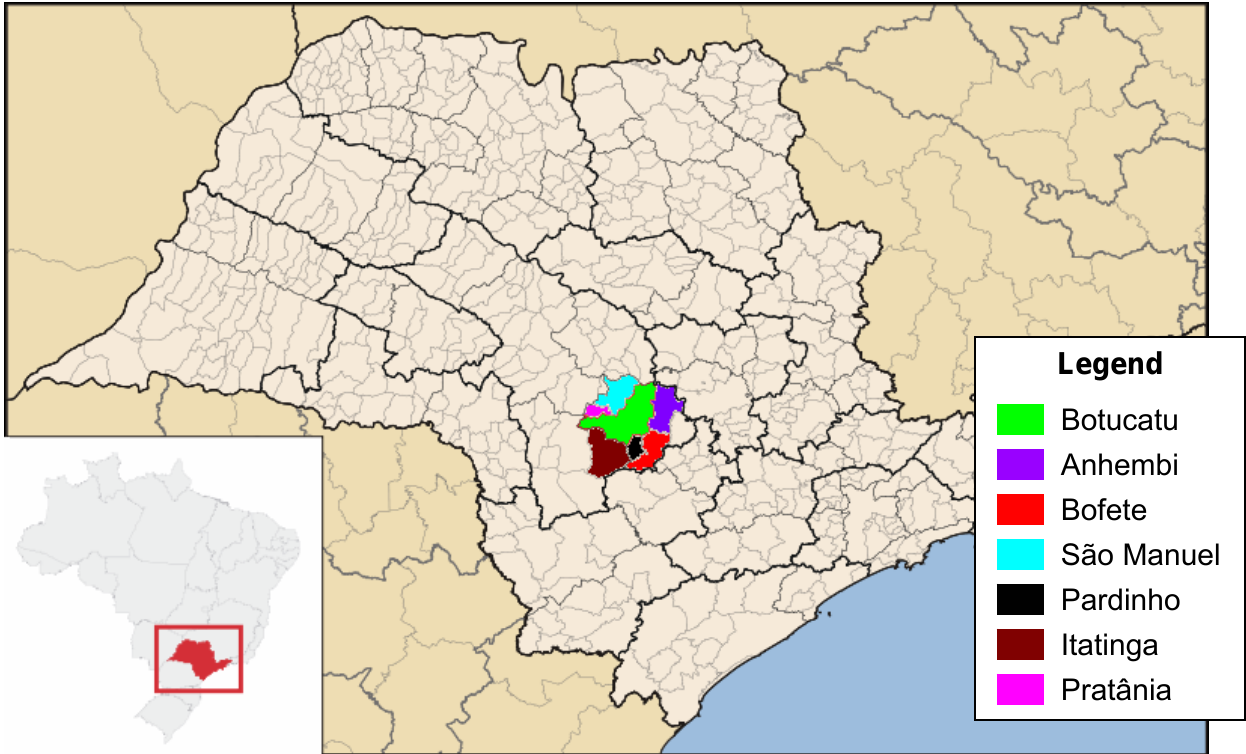
Figure 1. Cities comprising the Botucatu region – in São Paulo State, Brazil –where the vampire bats were captured in